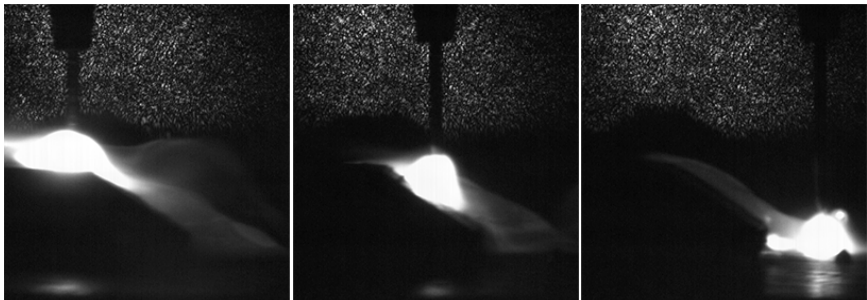
Figure 5. Arc images captured through high speed photography. Figure 5 . Arc images captured through high speed photography.